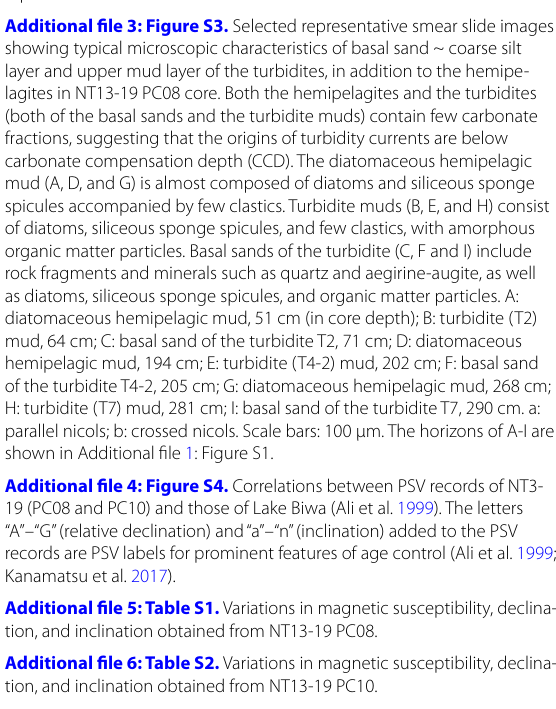
Additional file 1: Figure S1. High-resolution soft X radiographs and color photos of NT13-19 PC08. Solid arrow: basal part of turbidite (sand or coarse silt); dotted arrow: turbidite mud. T1-T12: turbidite numbers correspond to those in Figs. 2, 3, and 4. A-I: horizons of the smear slides in Additional file 3: Figure S3: Hr-FP: Haruna-Futatsudake-Ikaho tephra. Additional file 2: Figure S2. High-resolution soft X radiographs and color photos of NT13-19 PC10. . Solid arrow: basal part of turbidite (sand or coarse silt); dotted arrow: turbidite mud. T1–T11: turbidite numbers correspond to those in Figs. 2, 3, and 4. Hr-FP: Haruna-Futatsudake-Ikaho tephra.